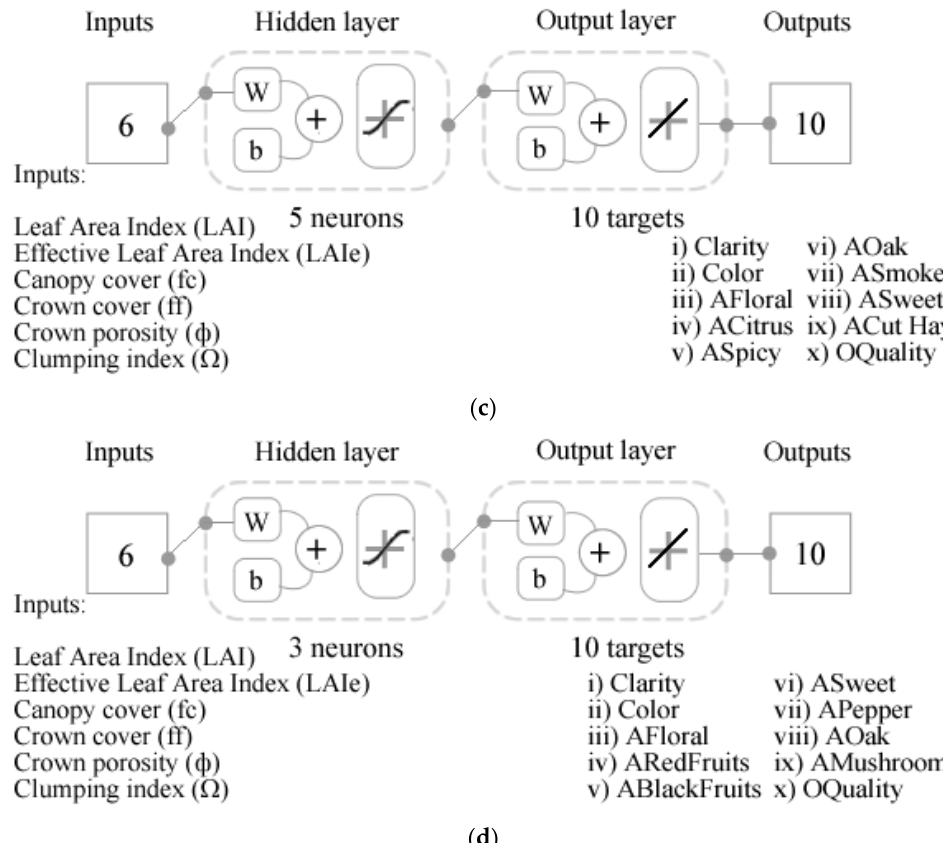
Figure 4. Diagrams representing the artificial neural network (ANN) two-layer feedforward models with a tan-sigmoid function in the hidden layer and a linear transfer function in the output layer.